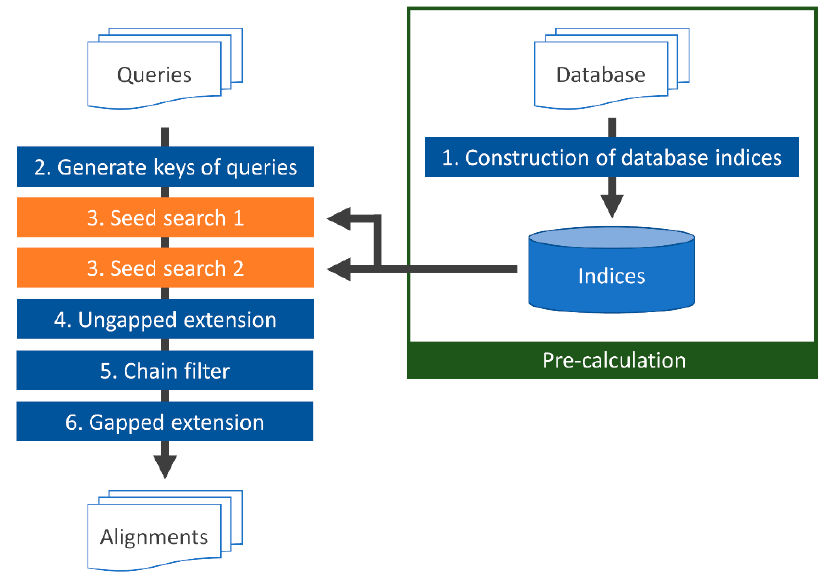
Figure 3. TSSS flowchart.